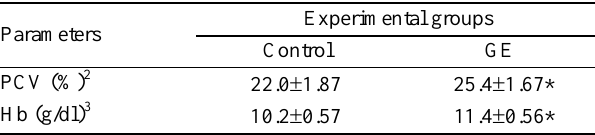
1 Values are means  SD of five fish for each group. Means with the asterisk * in the same row indicates significant difference (p<0.05) between two groups. 2 Hematocrit. 3 Hemoglobin.